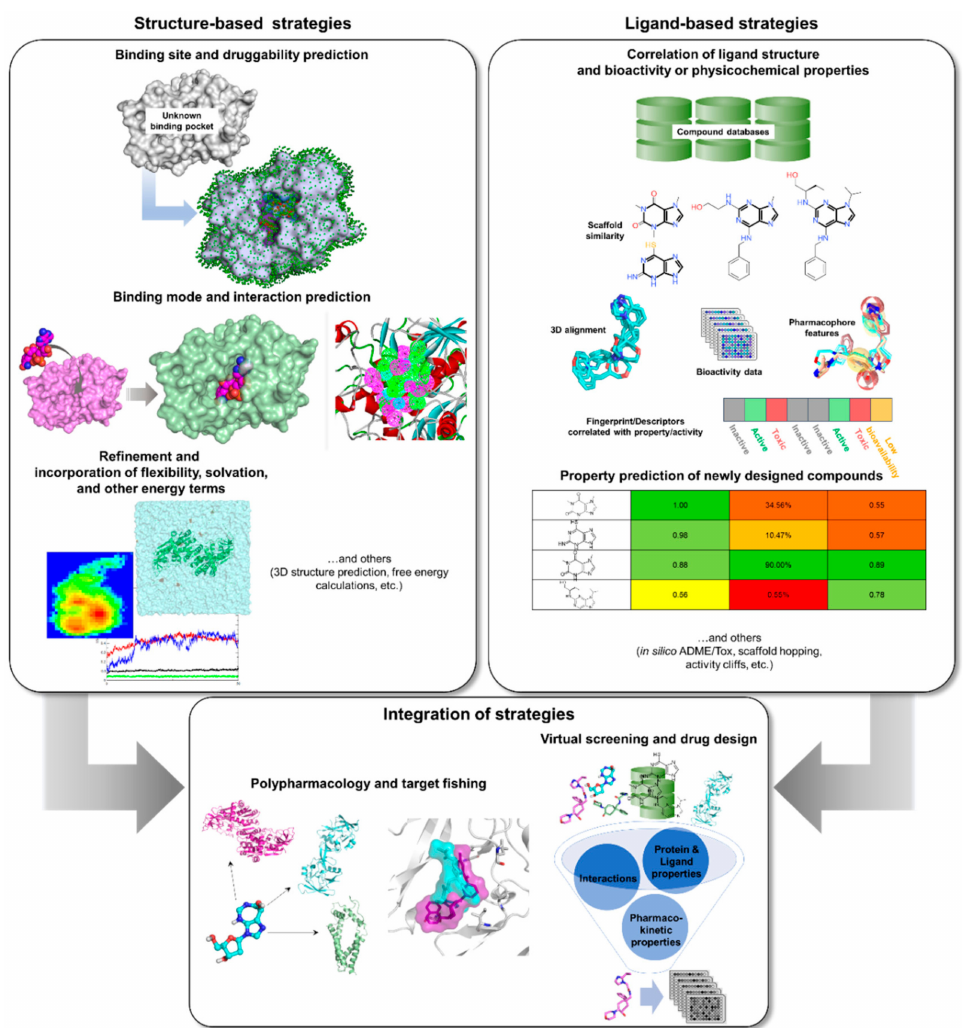
Figure 2. In silico tools that can be applied to TB drug design and